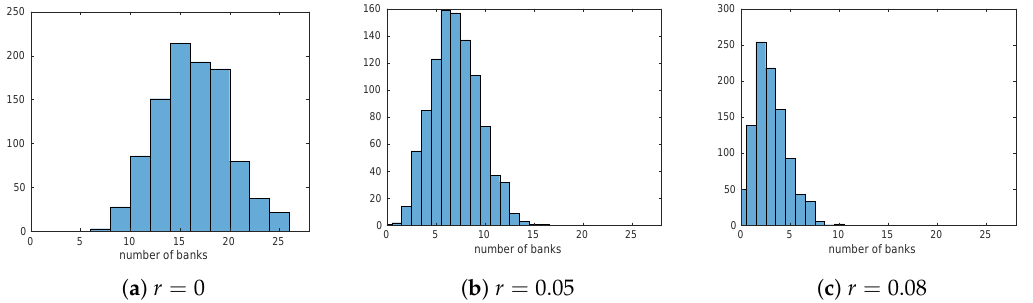
Figure 4. Number of banks in default, whose log capital Y i ( t ) at some time t ∈ [ 0, T ] goes below D = − 1. We use the following parameters: N = 100 banks, 1000 simulations, no correlation: a ij = σ 2 no interbank flows: c ij = 0 for i , j = 1, . . . , N , 100 time steps, and µ i , σ i , i = 1, . . . , N are i.i.d. uniform on [ 0.1,0.2 ]